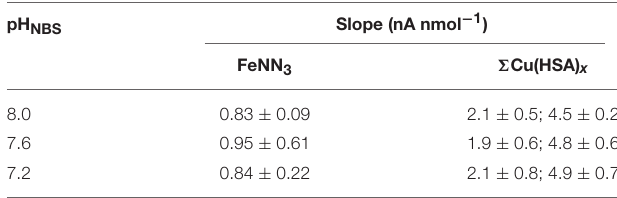
TABLE 1 | Average slopes observed for the last three titration points at different titration